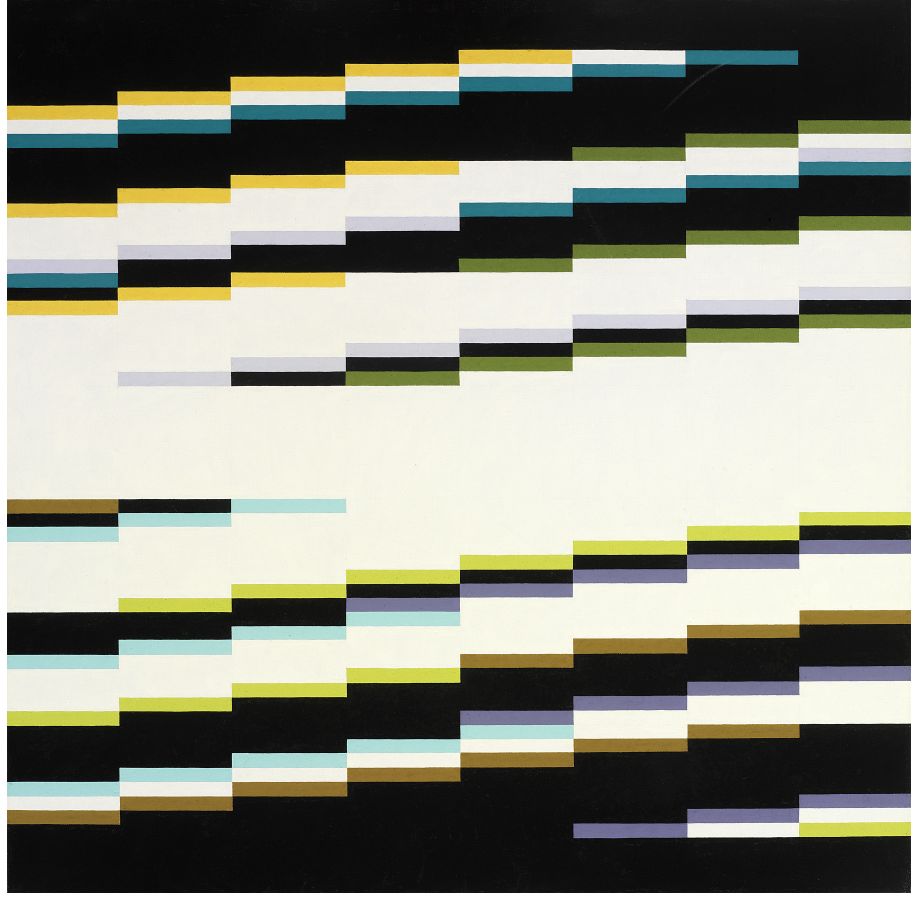
Figure 3: Syntagma SG III 104 , 1992, Oil on linen, 61 x 61cm. Copyright Jeffrey Steele, courtesy of Osborne